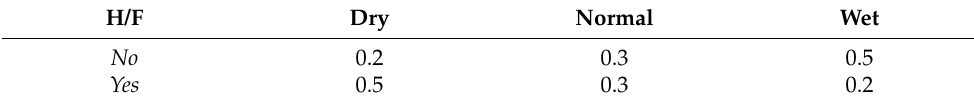
Table 1. Conditional Probability P( H/F ) [26]. Table 3. Conditional Probability P (S|F, D, H ) [26].